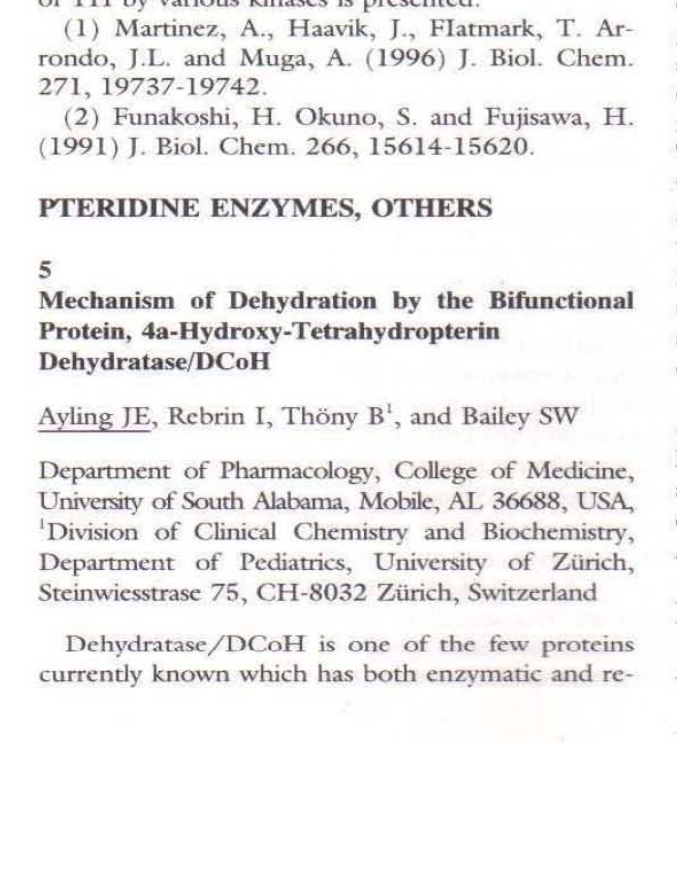
rylation partially reverses the competitive inhibi tion of catechoLamines versus the tetrahydropter idine. We have observed a linear